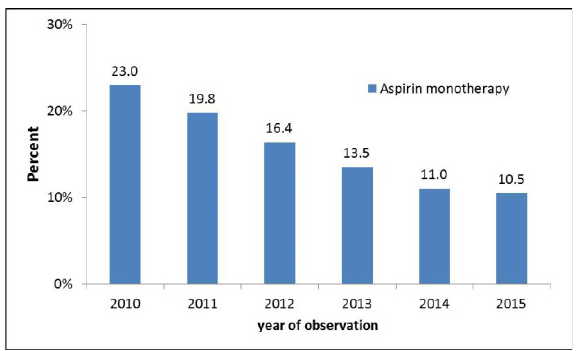
Figure 5: Use of aspirin monotherapy over time.